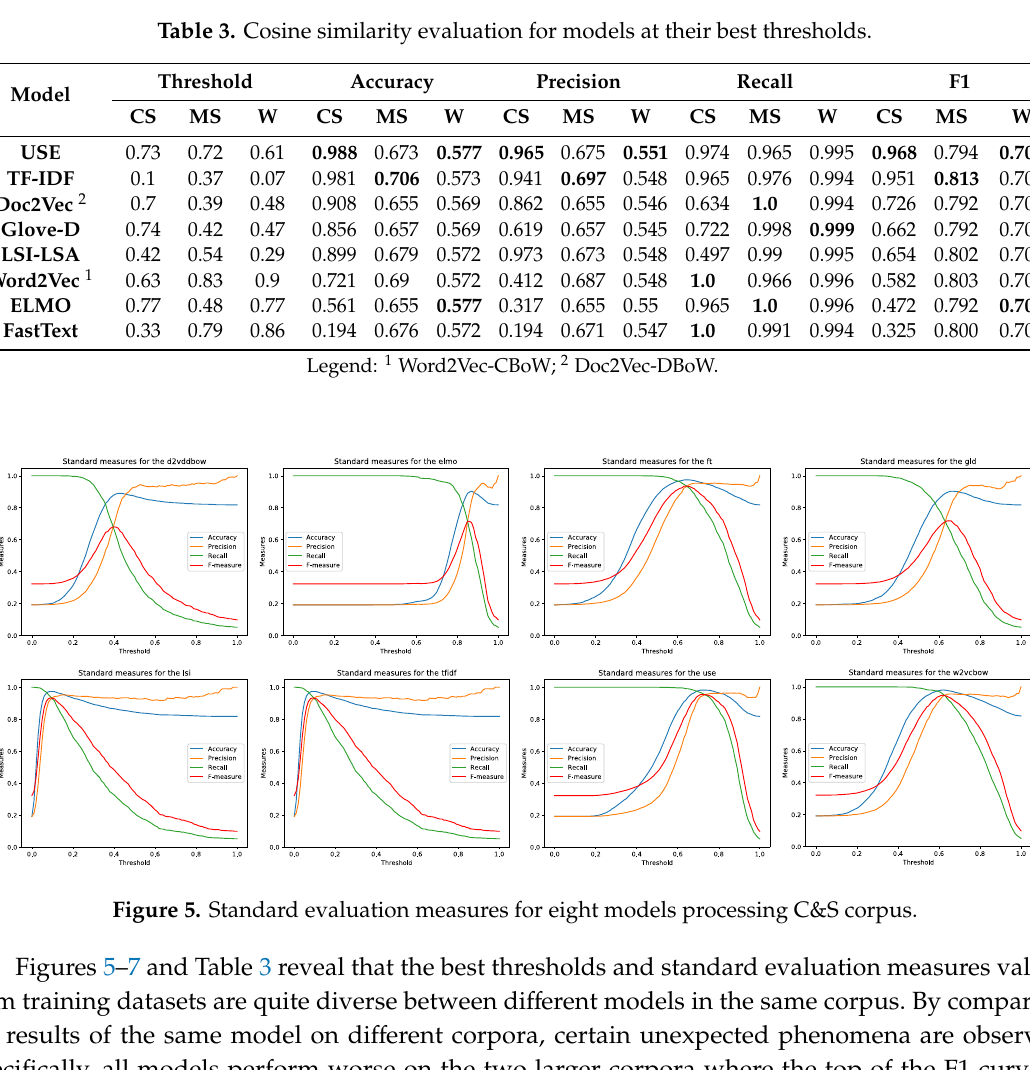
Figure 6. Standard evaluation measures for eight models processing MSRP corpus.